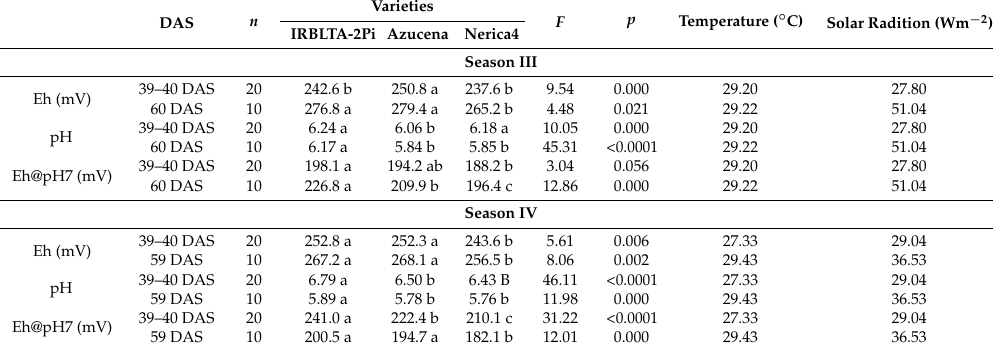
Figure 3. Intra-leaf variability of Eh (mV) ( A ), pH ( B ) and Eh@pH7 (mV) ( C ) respectively, for three leaf positions (Base, Middle, Tip), at two plant ages (40 and 59 DAS (days after sowing)), under two water management treatments (“Upland” = aerobic conditions, “Lowland” = anaerobic conditions). Error bars represent one standard deviation. Data are means of the last fully expanded leaf of the main tiller of three plants from season III, sown 13 January 2017. 3.3.2. Inter-Leaf Variability: Eh-pH “Gradients” in Rice Plants Leaf Eh and pH presented the same patterns in all rice plants and for all tillers and it was possible to group leaves according to their age, as seen in Figures 4, 5, and 6A,B and Tables S3.1–S3.7. Eh of the last (youngest) leaf was high and highly variable, as seen in Figure 4A, and correlated with leaf length. Eh of the last and second last fully expanded leaves (second and third leaf from the top of the tiller) was the lowest in the plant. Eh of the photosynthetically active leaves were either equal, as seen in Figures 5 and 6A, or, in most cases, increasing from the last fully expanded leaf to older leaves, from the second leaf from top to bottom of the plant, with a strong increase in old, dying leaves, as shown in Tables S3.1–S3.7.